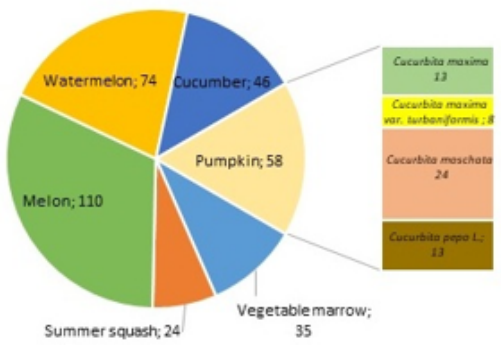
Figure 1. Structure of the base and active seed collections of the Cucurbitaceae family at the Scientific Centre of Veg- etable and Industrial Crops,